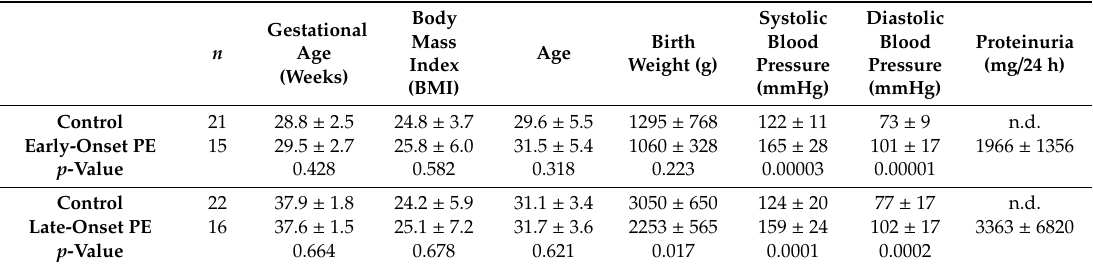
Table 1. Clinical information of preeclampsia (PE) patients and matched controls. Mean value ± standard derivation is